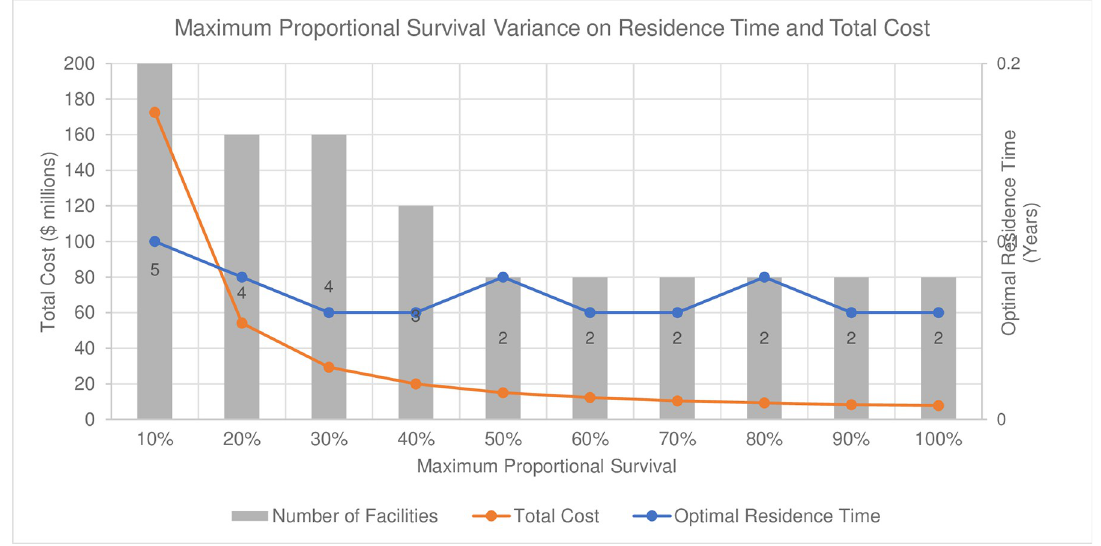
Fig 6. Maximum proportional survival variance. Optimal number of facilities (numbered in bars), total cost ($ million), and optimal growth time (years) relative to change in the maximum proportional survival limit for the base asymptotic survival function ( c = 25, t 0 =